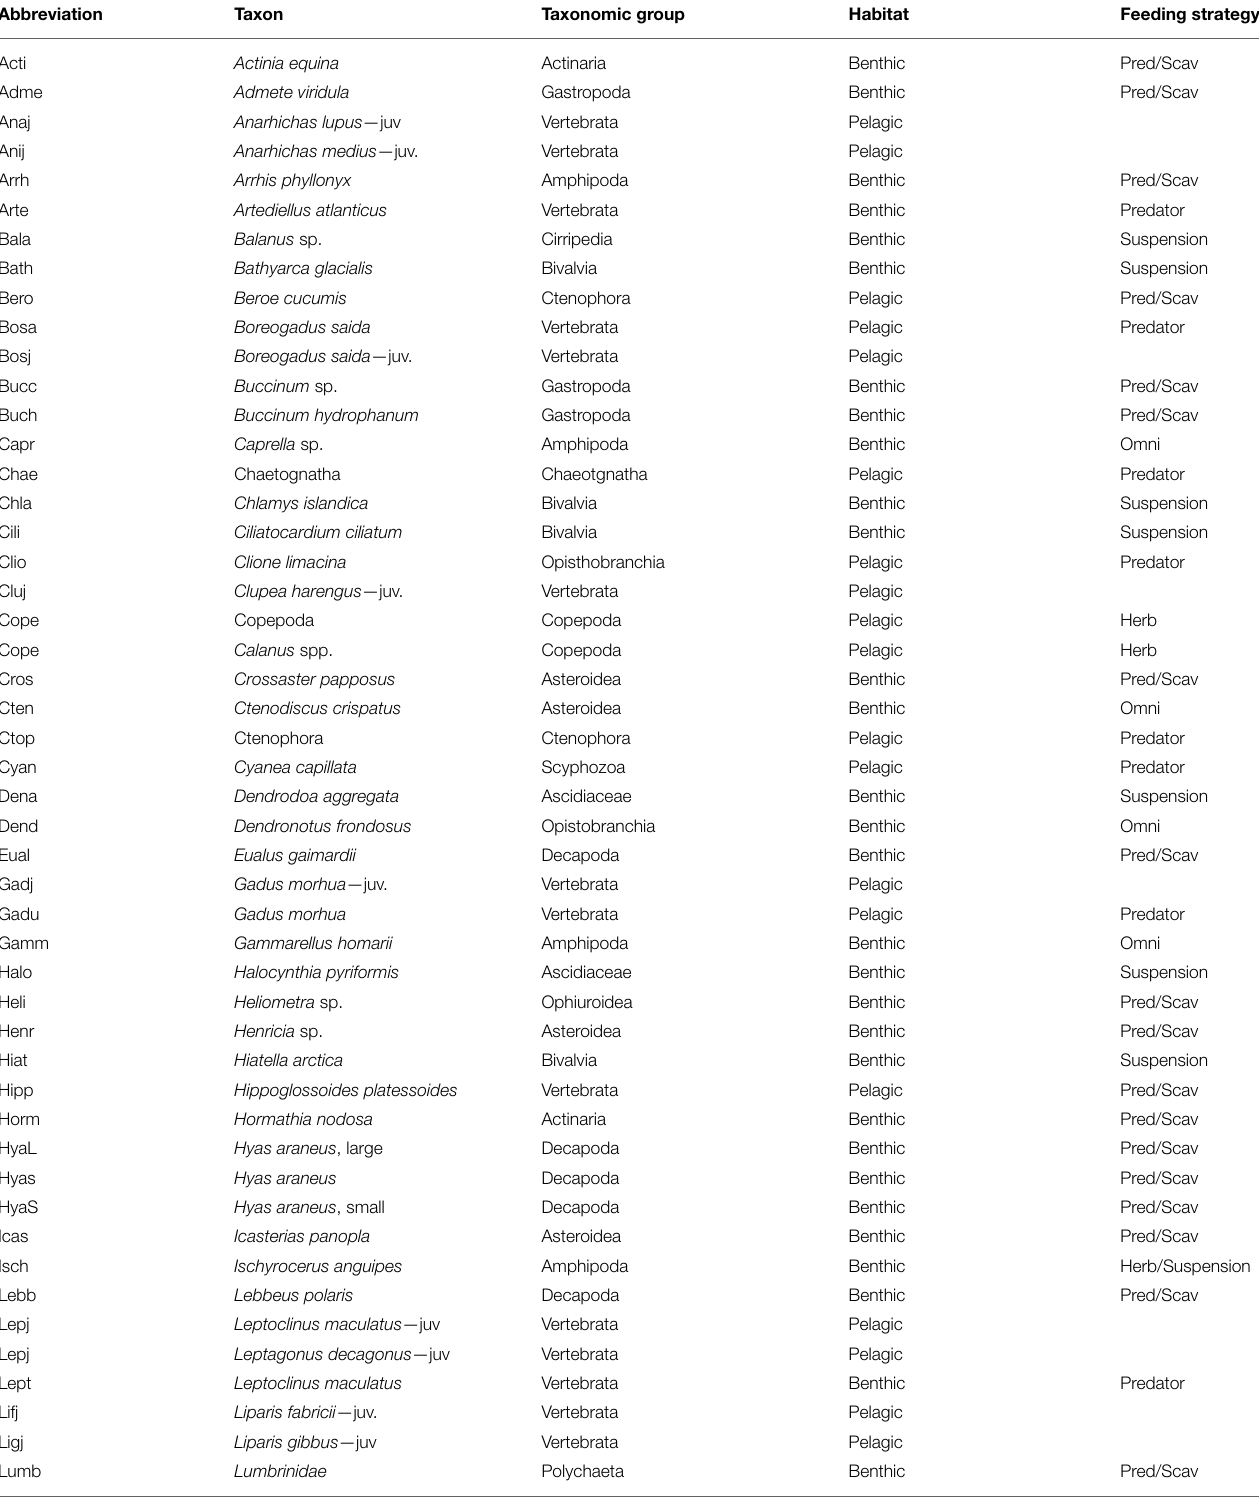
TABLE A1 | List of abbreviations used for taxa in Figure 4 and the taxon and larger taxonomic group referred